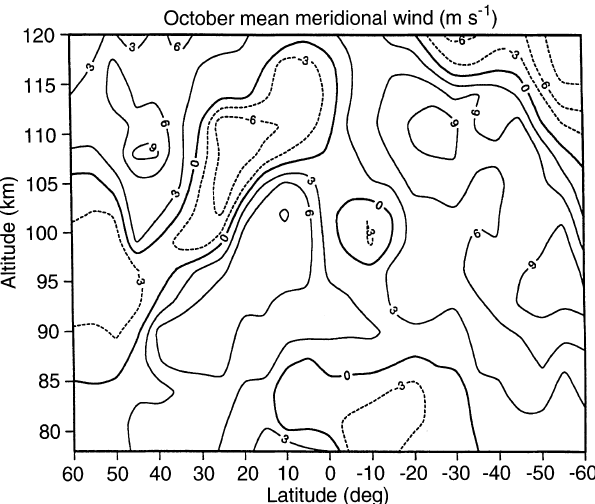
Fig. 4. Latitude-height distribution of the mean meridional wind in October